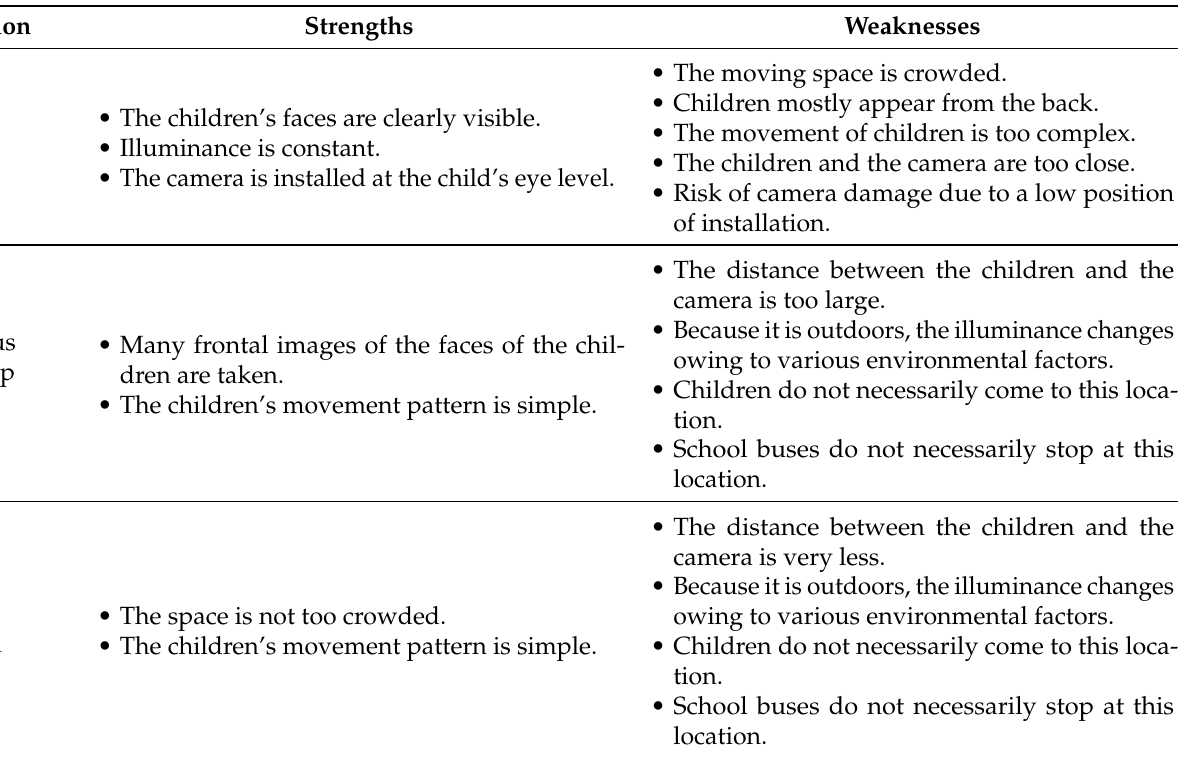
Table 5. The strengths and weaknesses of each camera installation